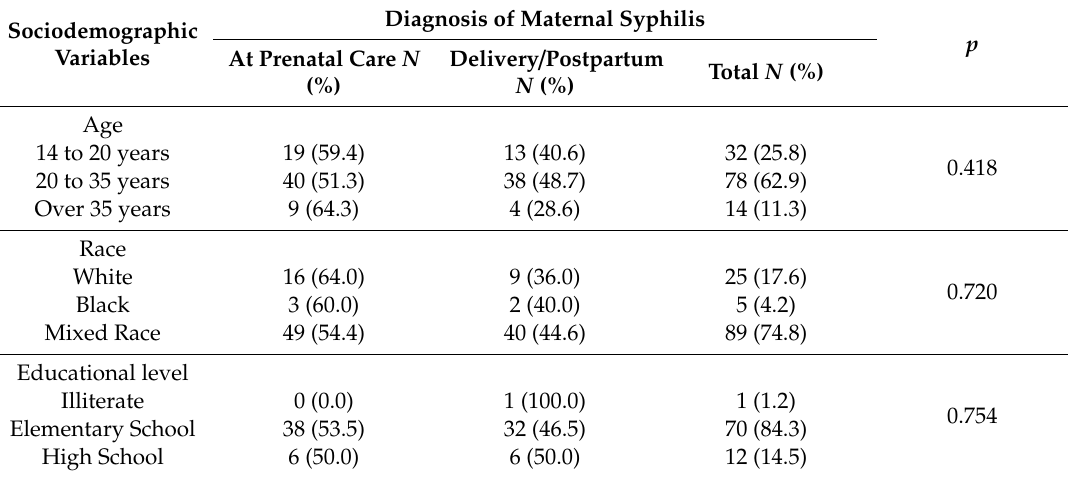
Table 2. Diagnosis of maternal syphilis according to sociodemographic variables, using Chi-Square and Fisher tests with a significance level of 5%. Natal, RN, Brazil, 2016 ( n = 129).